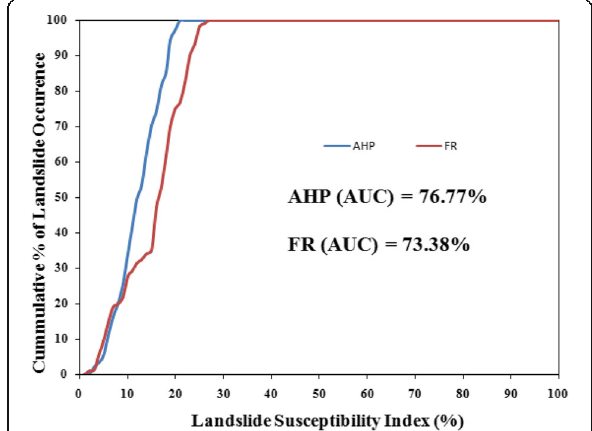
Fig. 7 Graph representing prediction rate curves of statistical model FR (Red trend line) and AHP (Blue trend line) for interpretation of model fitness for landslide susceptibility mapping and their respective AUC values